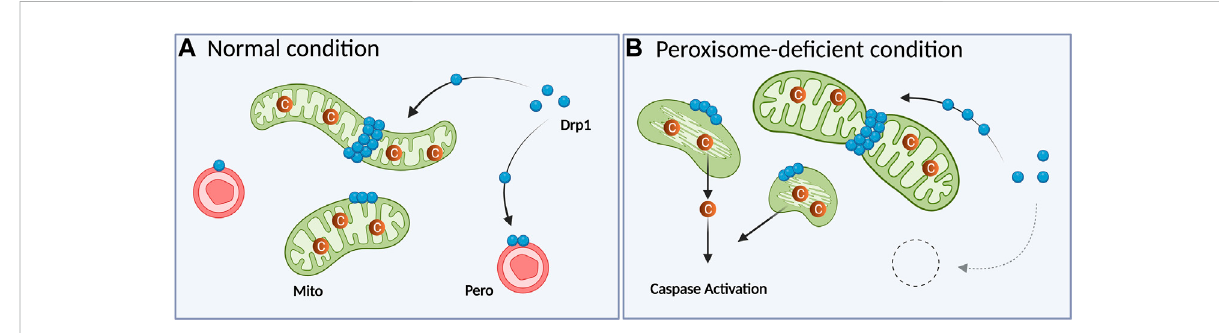
FIGURE 2 The absence of peroxisomes results in excess mitochondrial fragmentation following caspase activation in mammalian cells. (A) In normal conditions, cytosolic Drp1 is recruited to both peroxisomes and mitochondria. (B) When peroxisomes are acutely depleted by Pex3 KO, Drp1 is recruited to mitochondria more than WT cells. Translocated Drp1 will induce mitochondrial fragmentation along with abnormal cristae structures. This fragmentationinducesthereleaseof cytochrome cto thecytosol, resulting incaspase activation.Mito: mitochondrion,Pero: peroxisome, C: cytochrome c. The fi gure is created with